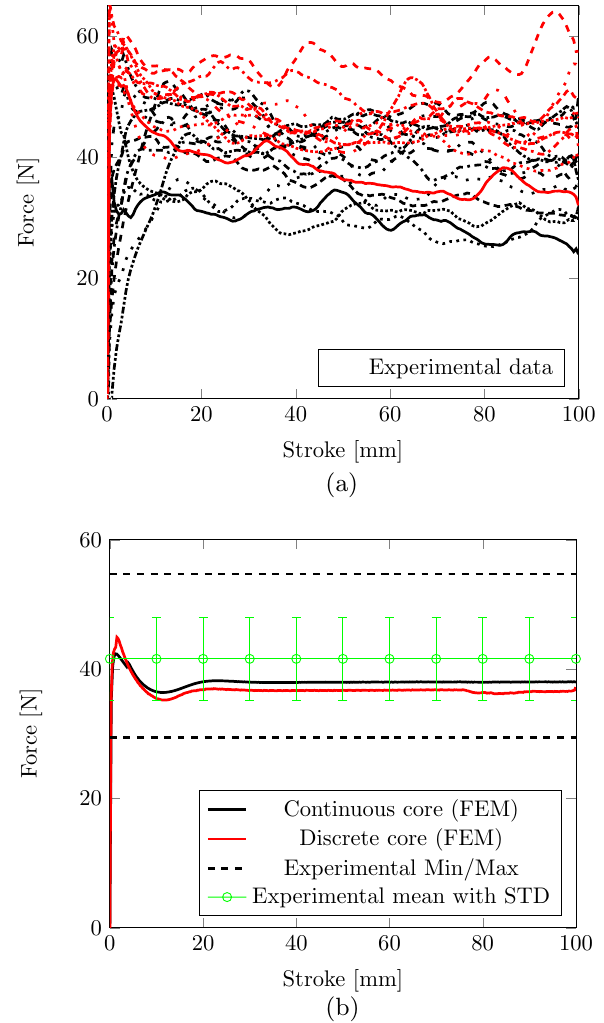
Fig. 15 a Experimental data of the T-peel test. b Mean and stand- ard deviation of the experimental data is presented and compared with the calibrated numerical models, i.e. the continuum represen- tation of the core and the discrete